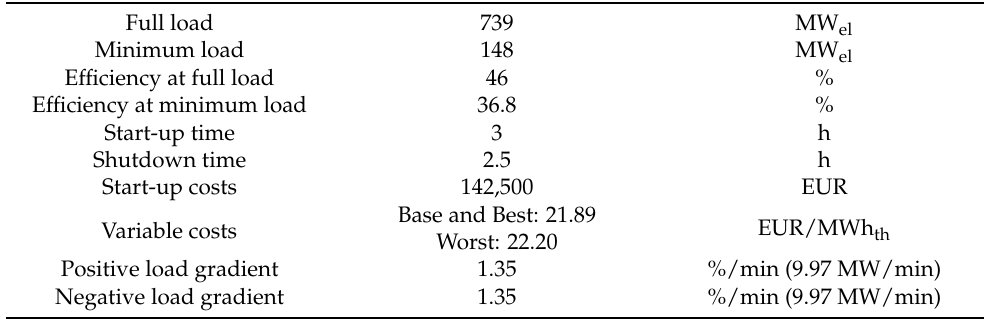
Table 4. Input parameters for the reference power plant.